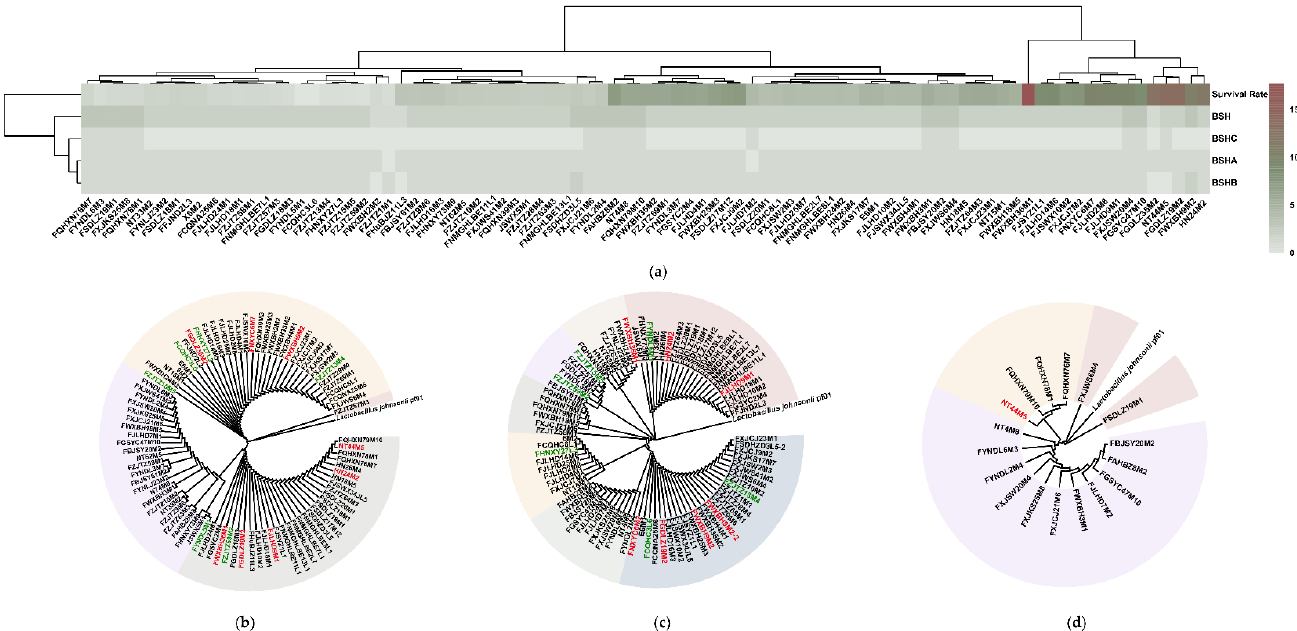
Figure 2. Number and phylogenetic trees of the three BSHs. ( a ) The number of three BSH types and the corresponding survival rate of each strain. The algorithm of hierarchical clustering was applied based on the Euclidean distance; ( b ) – ( d ) The phylogenetic trees of the strains’ BSHA, BSHB, and BSHC, respectively, using L. johnsonii PF01 as an outgroup. Strain names in red represent strains with survival rates higher than 9.5%; strain names in green represent strains with survival rates lower than 0.7%.